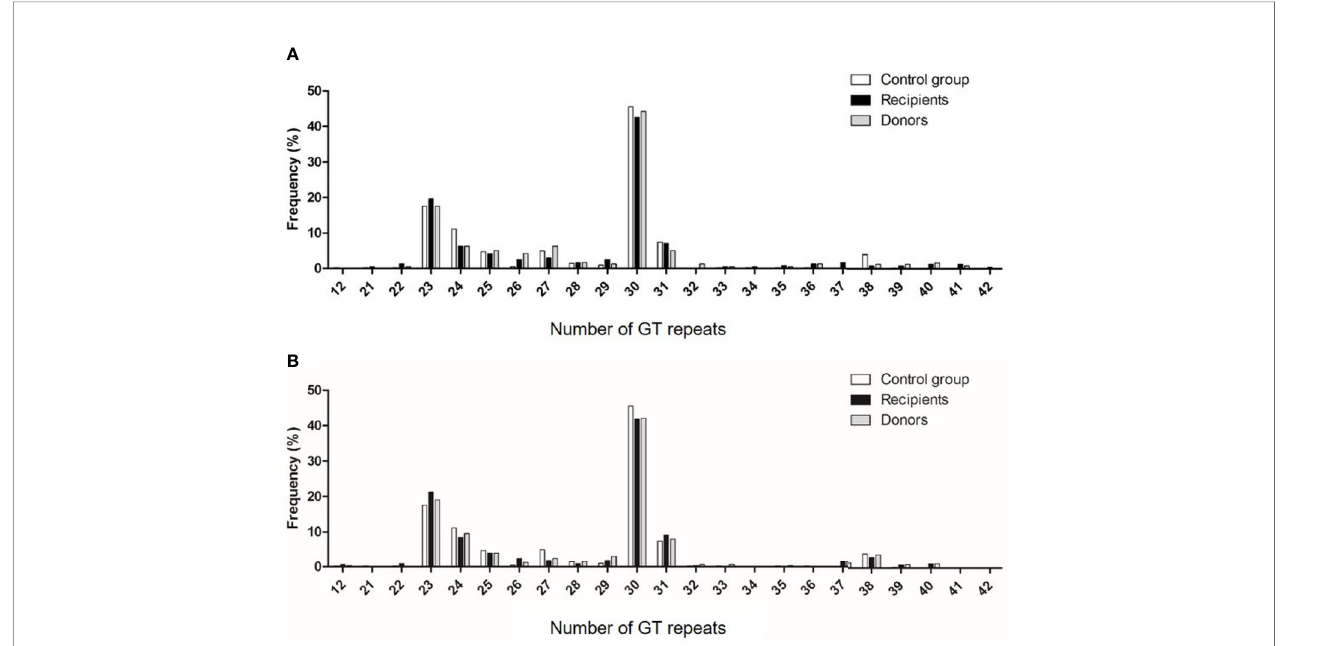
FIGURE 4 | Distribution of the number of (GT) n repeats in the microsatellite region of the HO-1 gene promoter. Numbers of (GT) repeats are shown in HSC donors (gray bars) and recipients (black bars) of cohorts 1 (A) and 2 (B) and in healthy volunteers (white